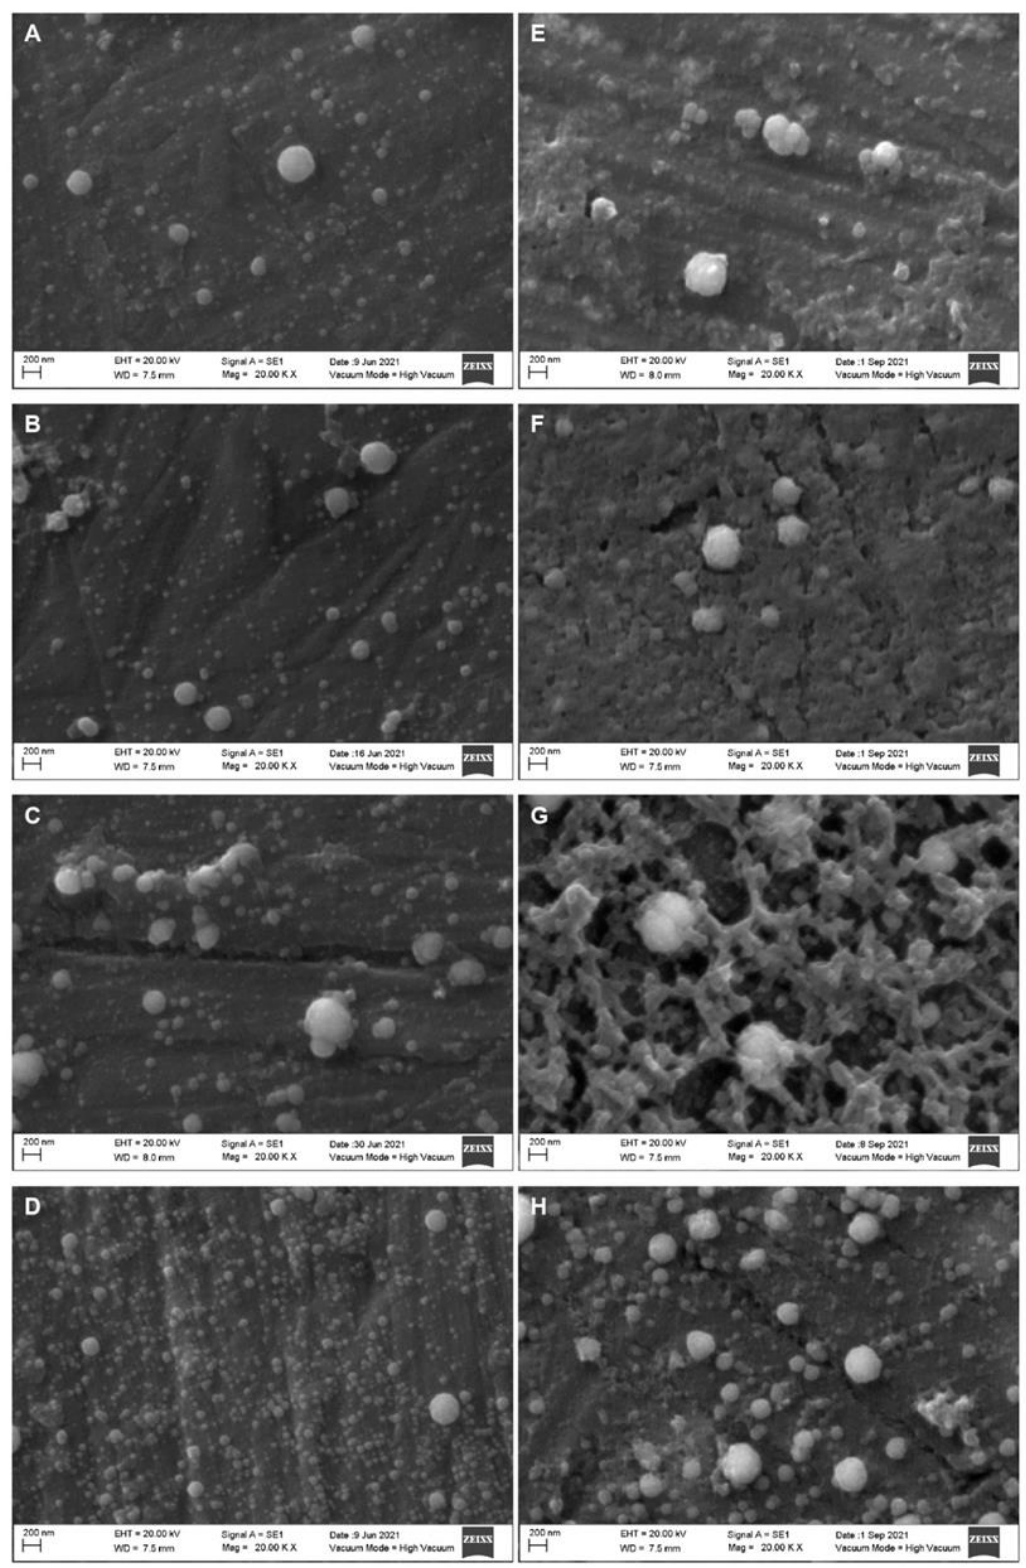
Figure 4. Scanning electron microscopy micrographs of homogenized whole (left column) and skim (right column) milk samples treated at 500 MPa. Come-Up Time ( A , E ); 2 min ( B , F ); 5 min ( C , G ); 10 min ( D , H ).